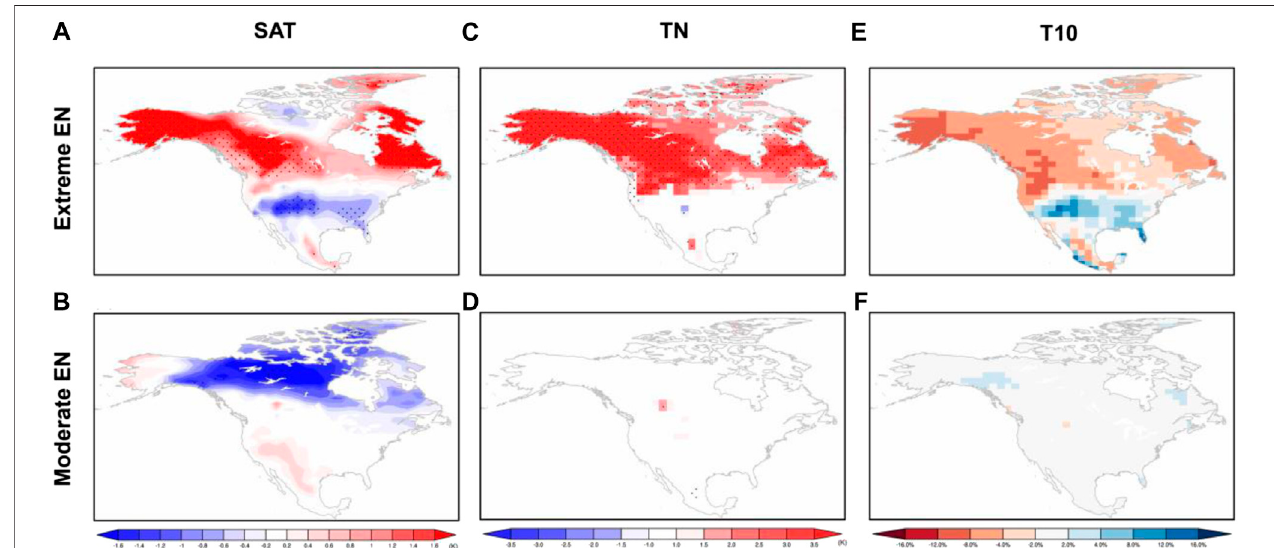
FIGURE 2 | Differences in mean extreme ( A and C , E ) and moderate ( B and D, F ) EN events from the 30-years (control run) climatological mean for surface air temperature(SAT; AandB ),thetemperatureofthecoldestdayinspring(TN; CandD ),andthefrequencyofcoldextremes(T10; EandF ).TNindicatestheresponseof the seasonal coldest night, and T10 is the change in the 10th percentile. Temperature anomalies in ( A and B, C, D ) that are signi fi cant at the 95% con fi dence level (Student ’ s t -test) are stippled.